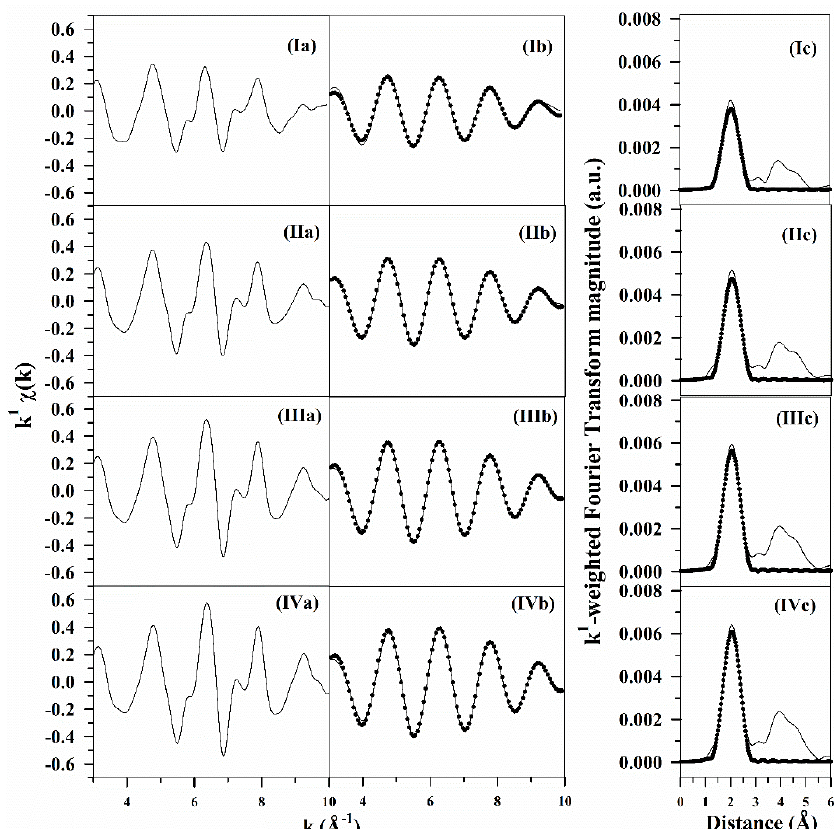
Figure 19. EXAFS fittings for Ni K-edge data, including ( a ) raw k 1 -weighted (k) data; ( b ) (solid line) filtered k 1 -weighted (k) data and (filled circles) results of the fittings; ( c ) (solid line) raw k 1 -weighted Fourier transform magnitude and (solid line) filtered k 1 -weighted Fourier transform magnitude; and (filled circles) results of the fittings for ( I ) 25%M (M = 5%Ni-95%Co) / Al 2 O 3 , ( II ) 25%M (M = 10%Ni-90%Co) / Al 2 O 3 , ( III ) 25%M (M = 25%Ni-75%Co) / Al 2 O 3 , and ( IV ) 25%M (M = 50%Ni-50%Co) / Al 2 O 3 .